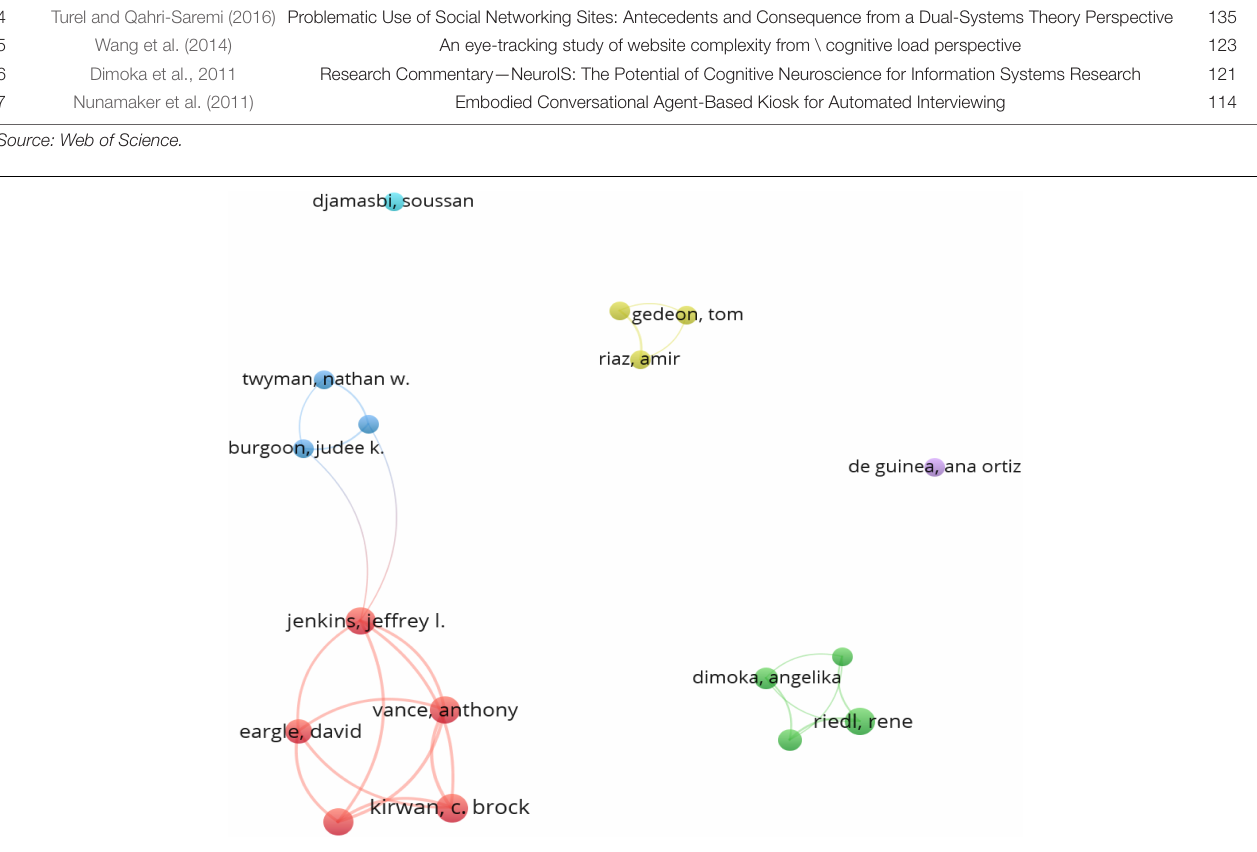
FIGURE 3 | Co-author network of authors with more than three publications.